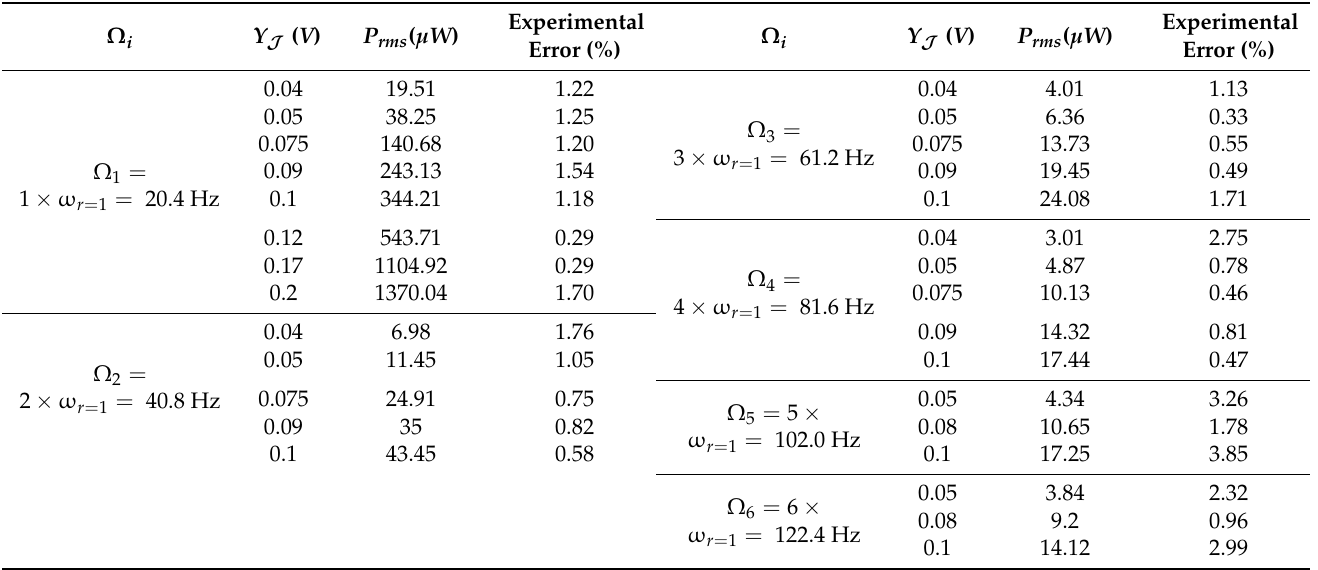
Table 3. Base excitation signal characteristics and experimental results obtained by connecting harvester to optimum